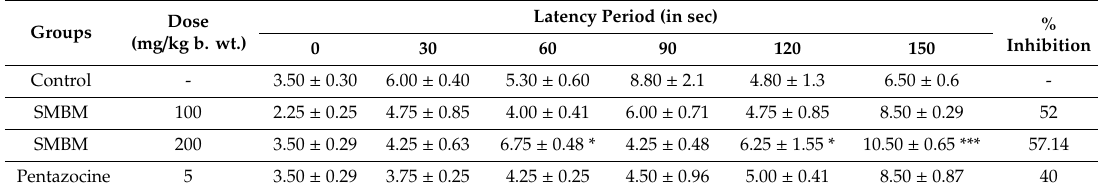
Table 2. E ff ect of SMBM against hot plate method induced pain.